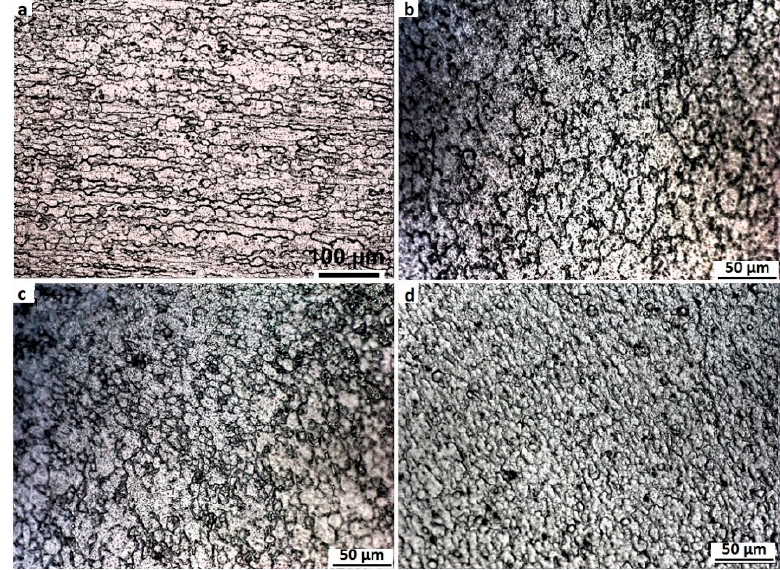
Figure 6. Microstructure of different regions of a BFSW A6082-T6 weld processed by etchant D; ( a ) B.M; ( b ) Heat Affected Zone (HAZ); ( c ) Thermo-mechanical Affected Zone (TMAZ); ( d ) S.Z.